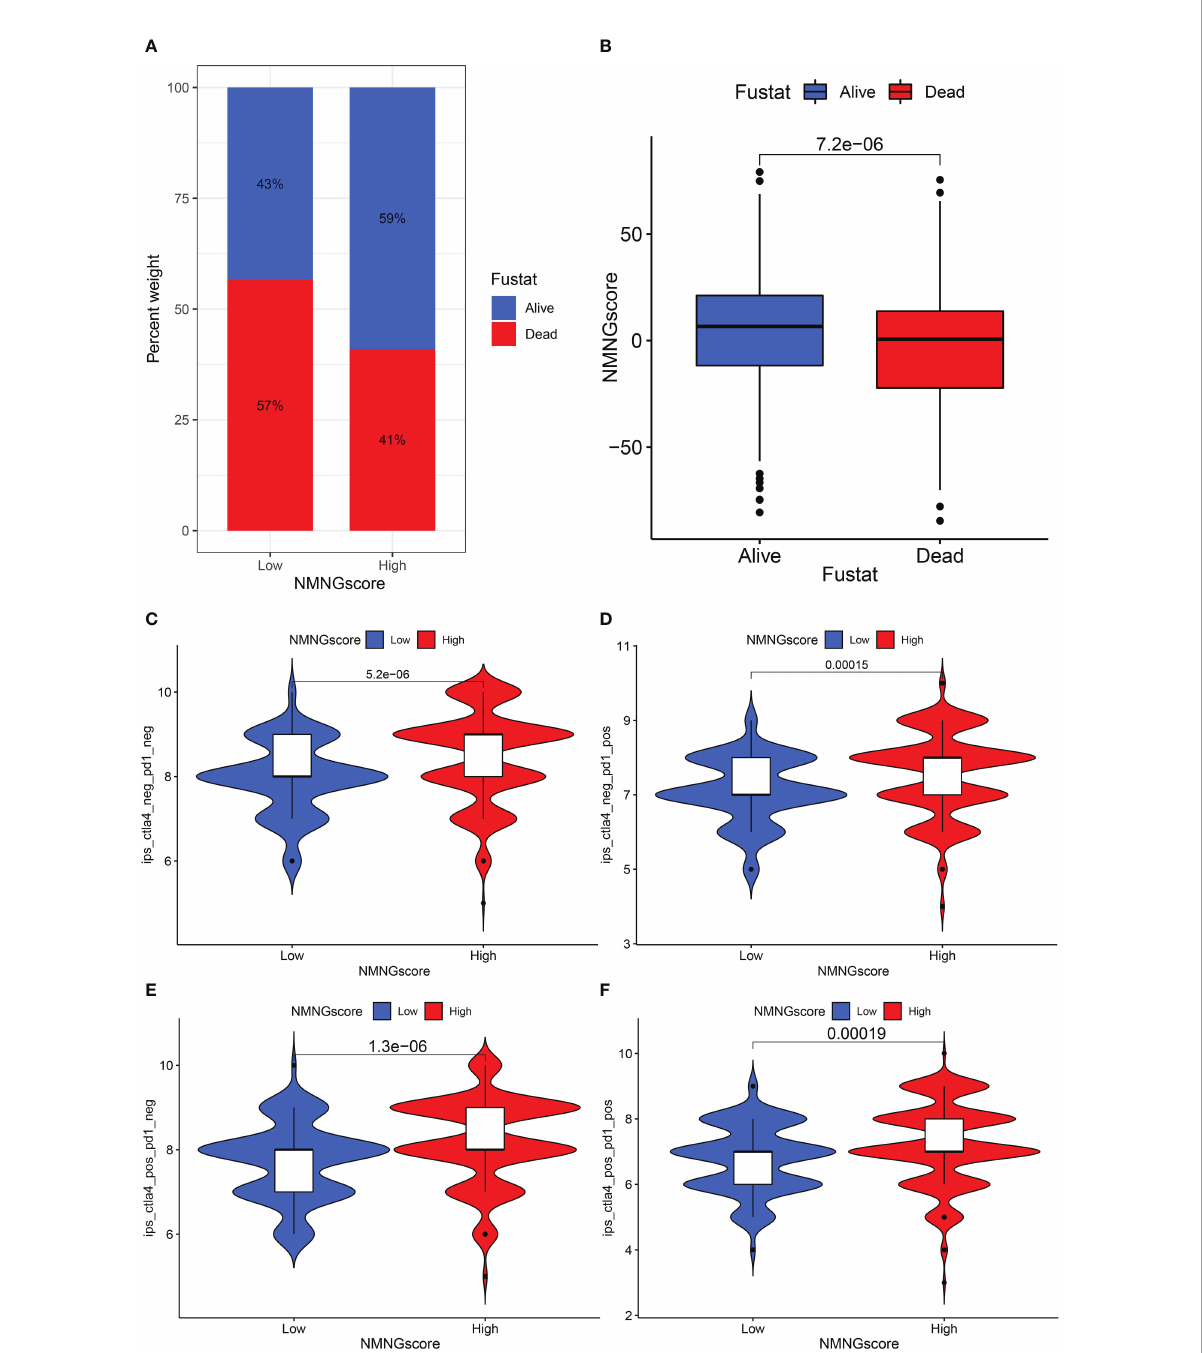
FIGURE 9 The role of NNMG-scoring signature in immunotherapy. (A) The proportion of patients surviving between the low and high NMNG score groups, with a higher proportion surviving in the high scoring group. (B) NMNG scores were higher in surviving patients than in patients who died. (C – F) The comparison of the relative distribution of immunophenoscore (IPS) between low and high NMNG score